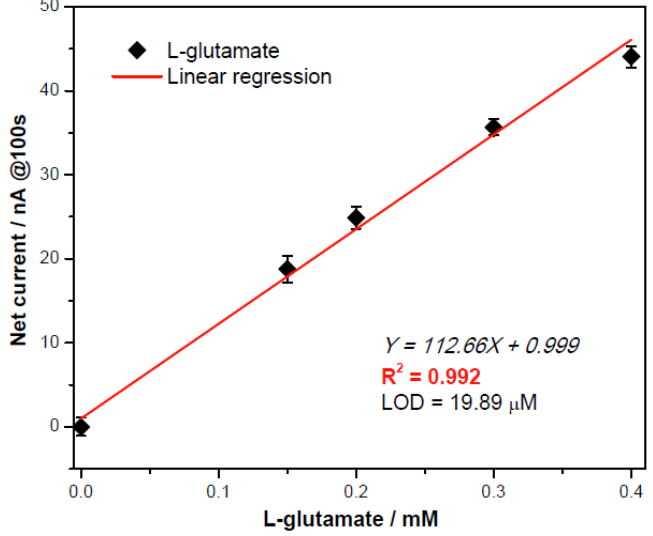
Figure 3. Calibration plot obtained at the 100th second for L-glutamate assessment by 0.05 U/µL GluOx obtained at +0.3 V versus the printed Ag/AgCl with repeatability demonstrated with a new sensor for each measurement (n =